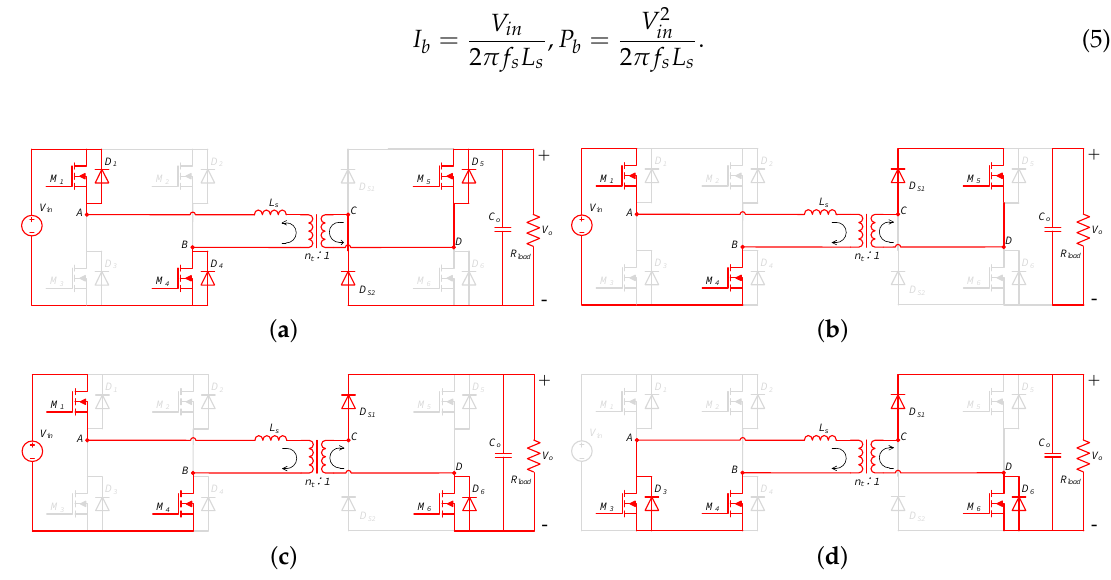
Figure 3. Equivalent circuits corresponding to the first four intervals in Mode A: ( a ) Interval 1 [0, β − α ]; ( b ) Interval 2 [ β − α , φ − α ]; ( c ) Interval 3 [ φ − α , π − α ]; ( d ) Interval 4 [ π − α , π